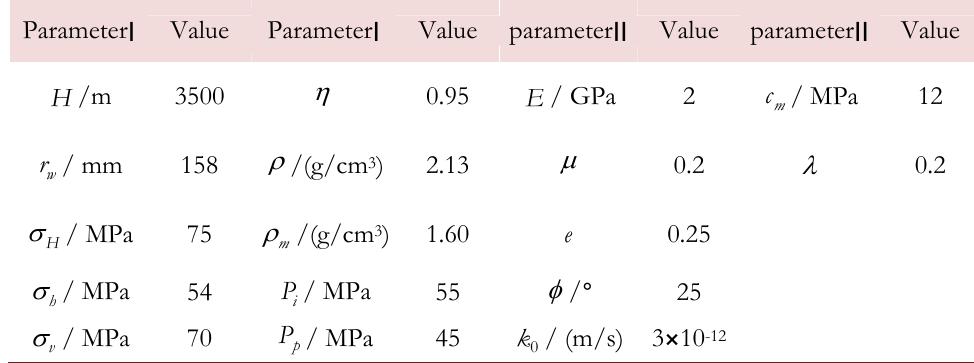
Table 1: Model parameters.